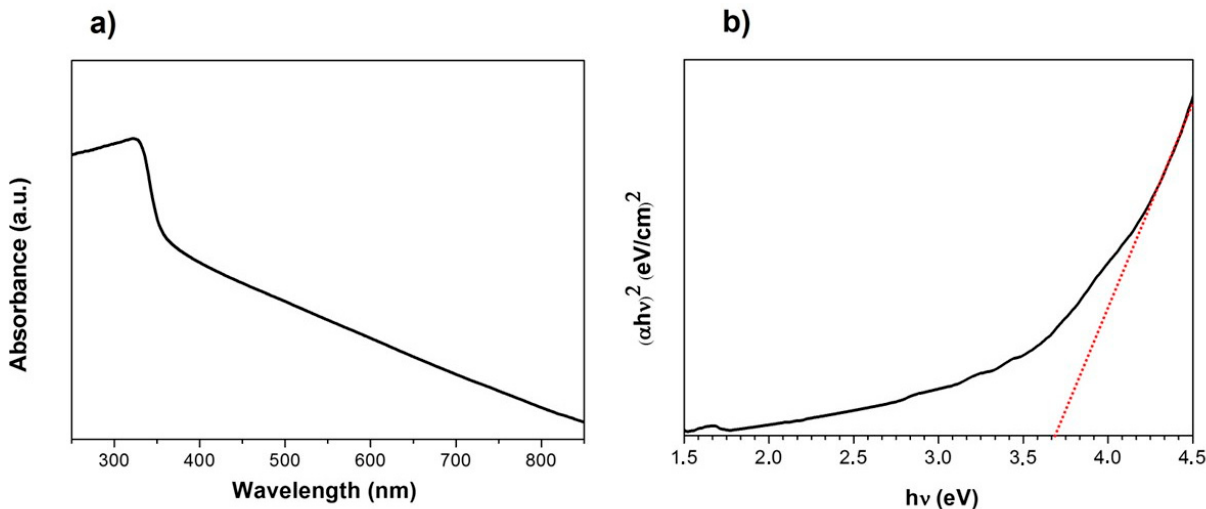
Figure 2. ( a ) UV-vis absorption spectrum of ZnS nanoparticles. ( b ) Tauc Plot obtained from UV-vis absorption spectrum.